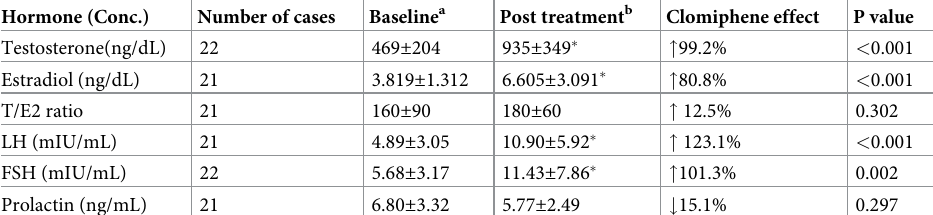
Table 1. Endocrinology data at baseline and 4 weeks after initiating clomiphene treatment. Hormone (Conc.) Number of cases Baseline a Post treatment b Clomiphene effect P value Testosterone(ng/dL) 22 Estradiol